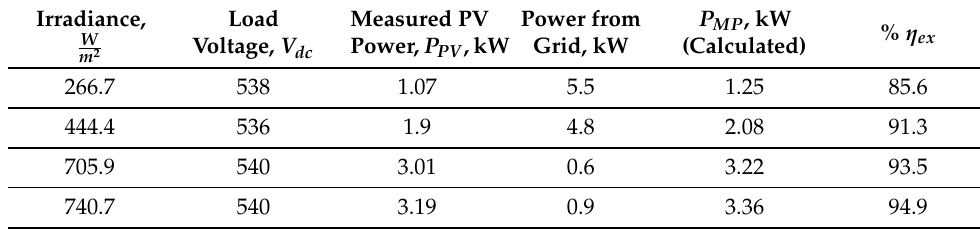
Table 2. Estimation of extraction efficiency in our